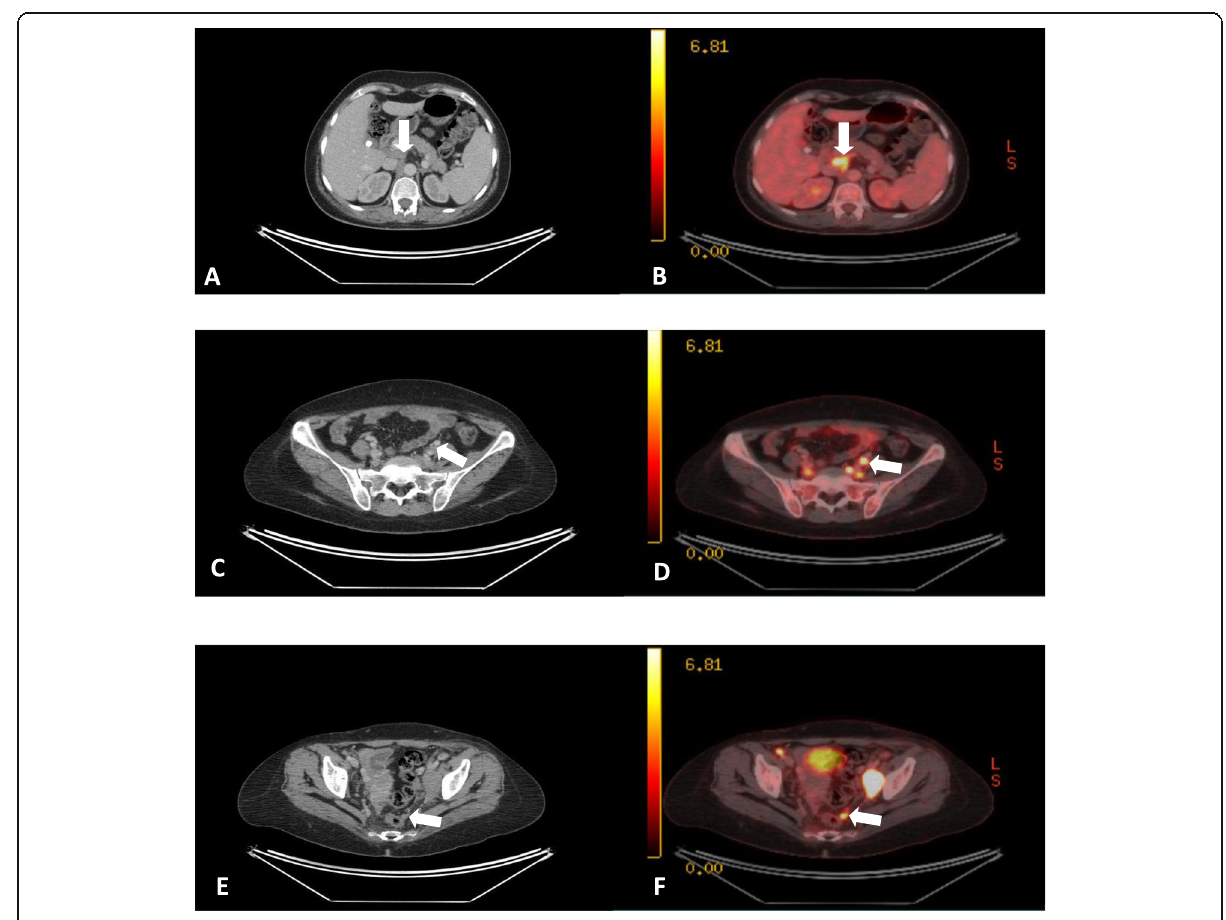
Fig. 1 Thirty-seven-year-old patient, known case of non-Hodgkin lymphoma. Multiple infradiaphragmatic metabolically active lymph nodes seen at the following sites: celiac, aortocaval, precaval ( a and b ); paraaortic, bilateral common iliac, bilateral internal ( c and d ); and external iliac and left para rectal ( e and f ), with the largest in precaval measuring 23.3 × 14.7 mm with SUV max 10.5, consistent with a score of 4 on the five-point scale